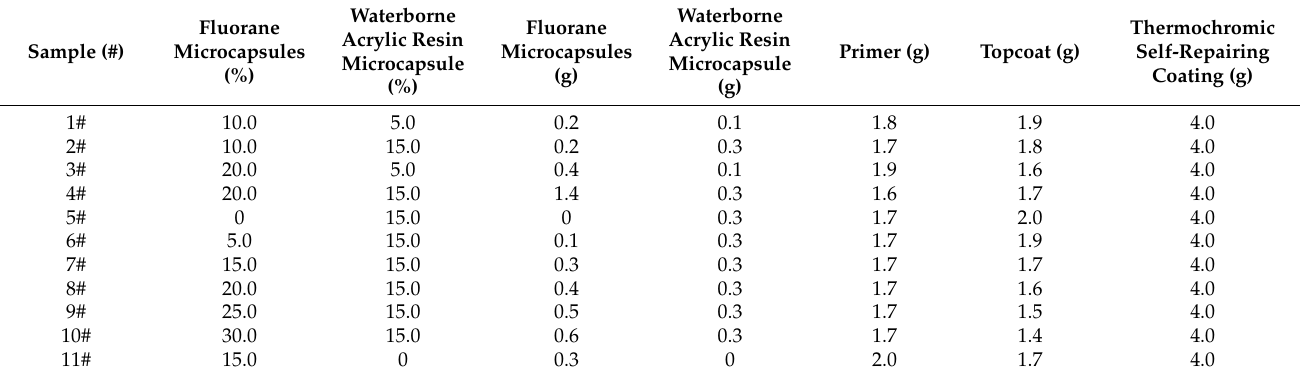
Table 3. Ingredients of thermochromic self-repairing